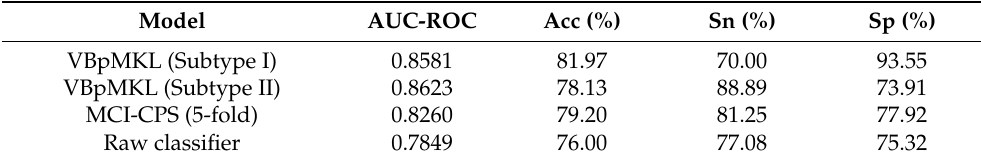
Table 1. Comparison of methods for predicting conversion from MCI to AD between MCI-CPS (5-fold) and Raw classifier (5-fold) with 5-fold cross-validation in ADNI-1. Model AUC-ROC Acc (%) VBpMKL (Subtype I) AUC, area under ROC curve; Acc, accuracy; Sn, sensitivity; Sp, specificity. First and second rows indicate performance of VBpMKL in subtypes I and II, respectively. Third row represents classification performance of MCI-CPS (5-fold). Fourth row represents classification performance of Raw classifier (5-fold), which was constructed without subtyping.